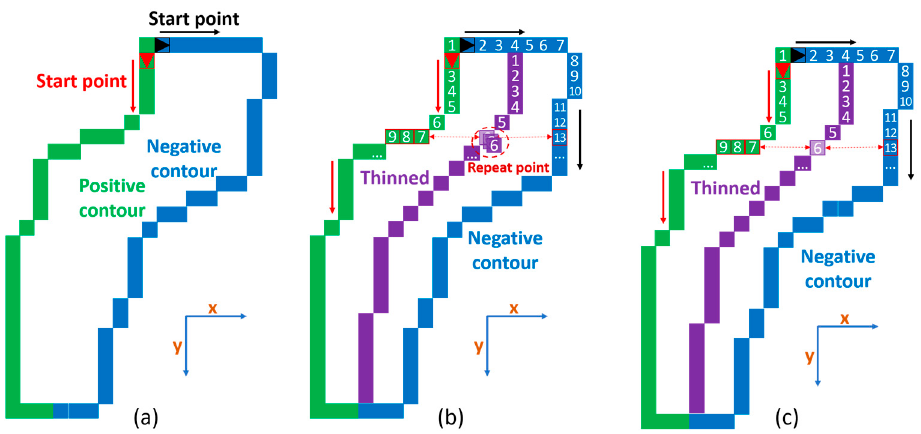
Figure 7. Flowchart of the proposed crack skeleton extraction algorithm.